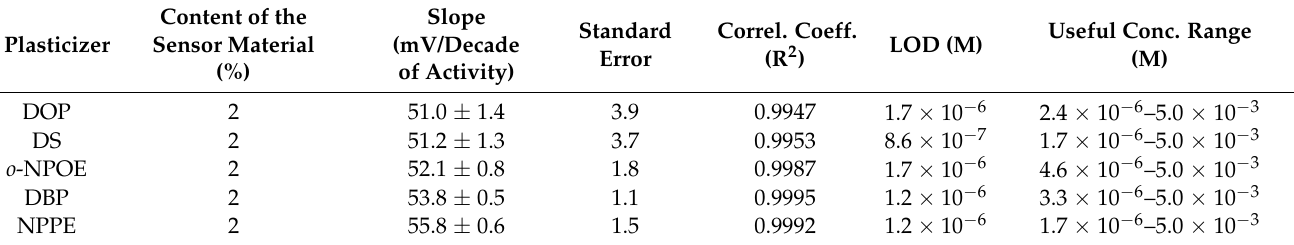
Table 2. Statistics of the response characteristics of the PM sensors with different plasticizers, to PM 1 .